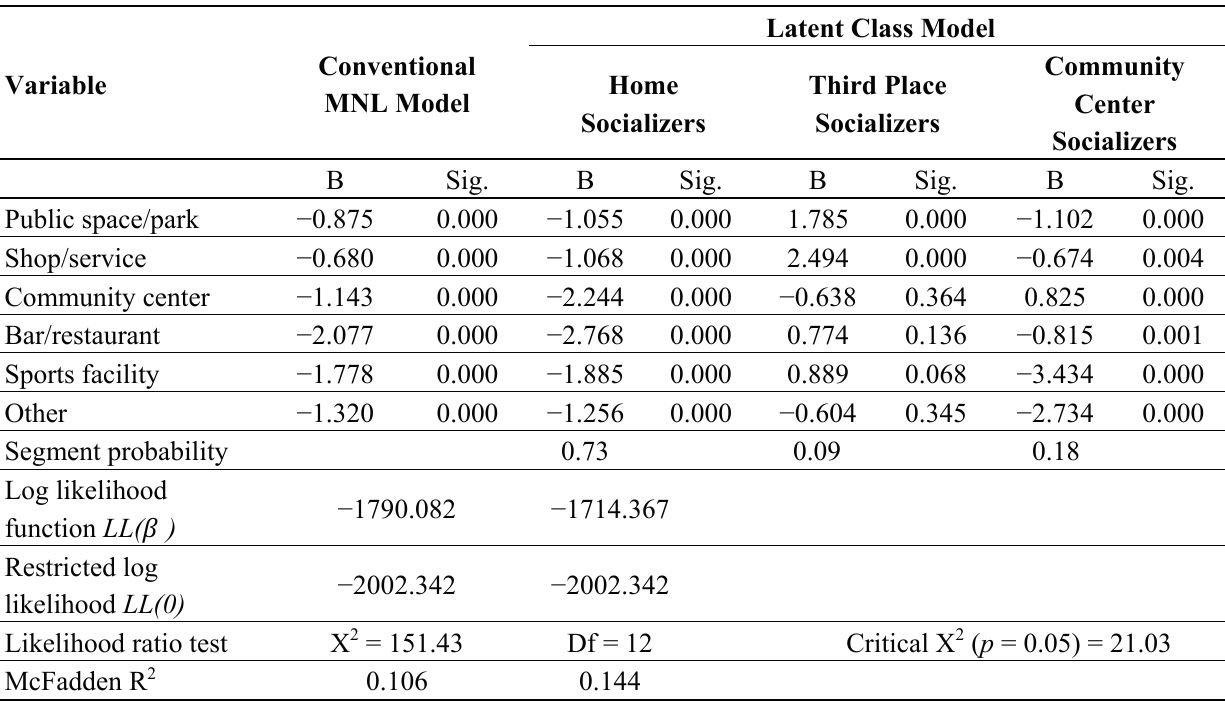
Table 4. Modeling